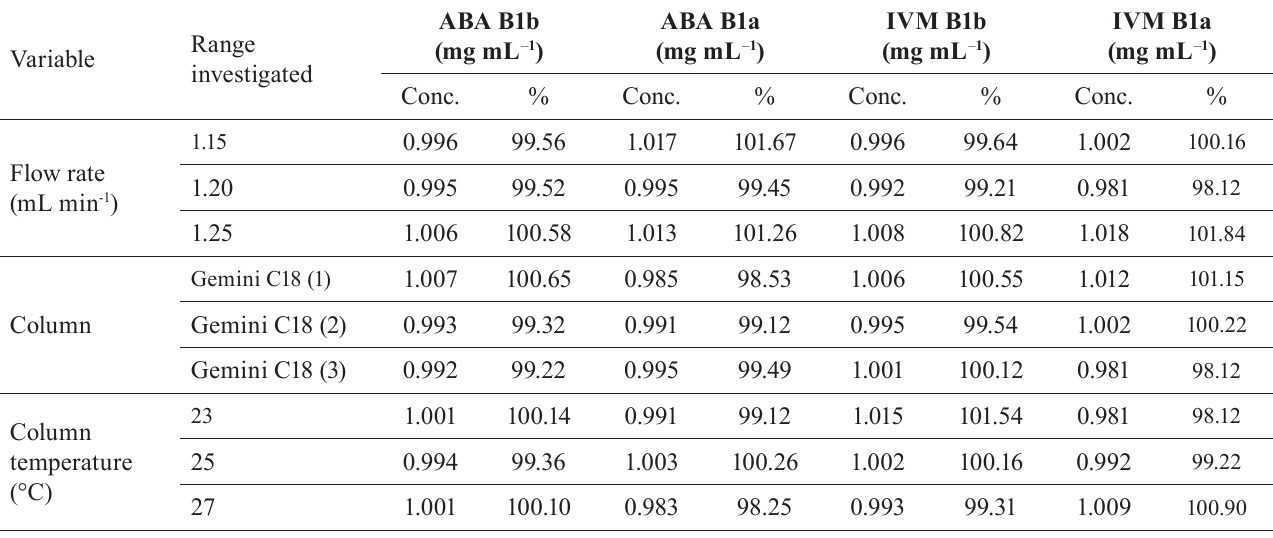
TABLE VIII - Chromatographic conditions and range investigated during robustness testing for ABA B1b, ABA B1a, IVM B1b and IVM